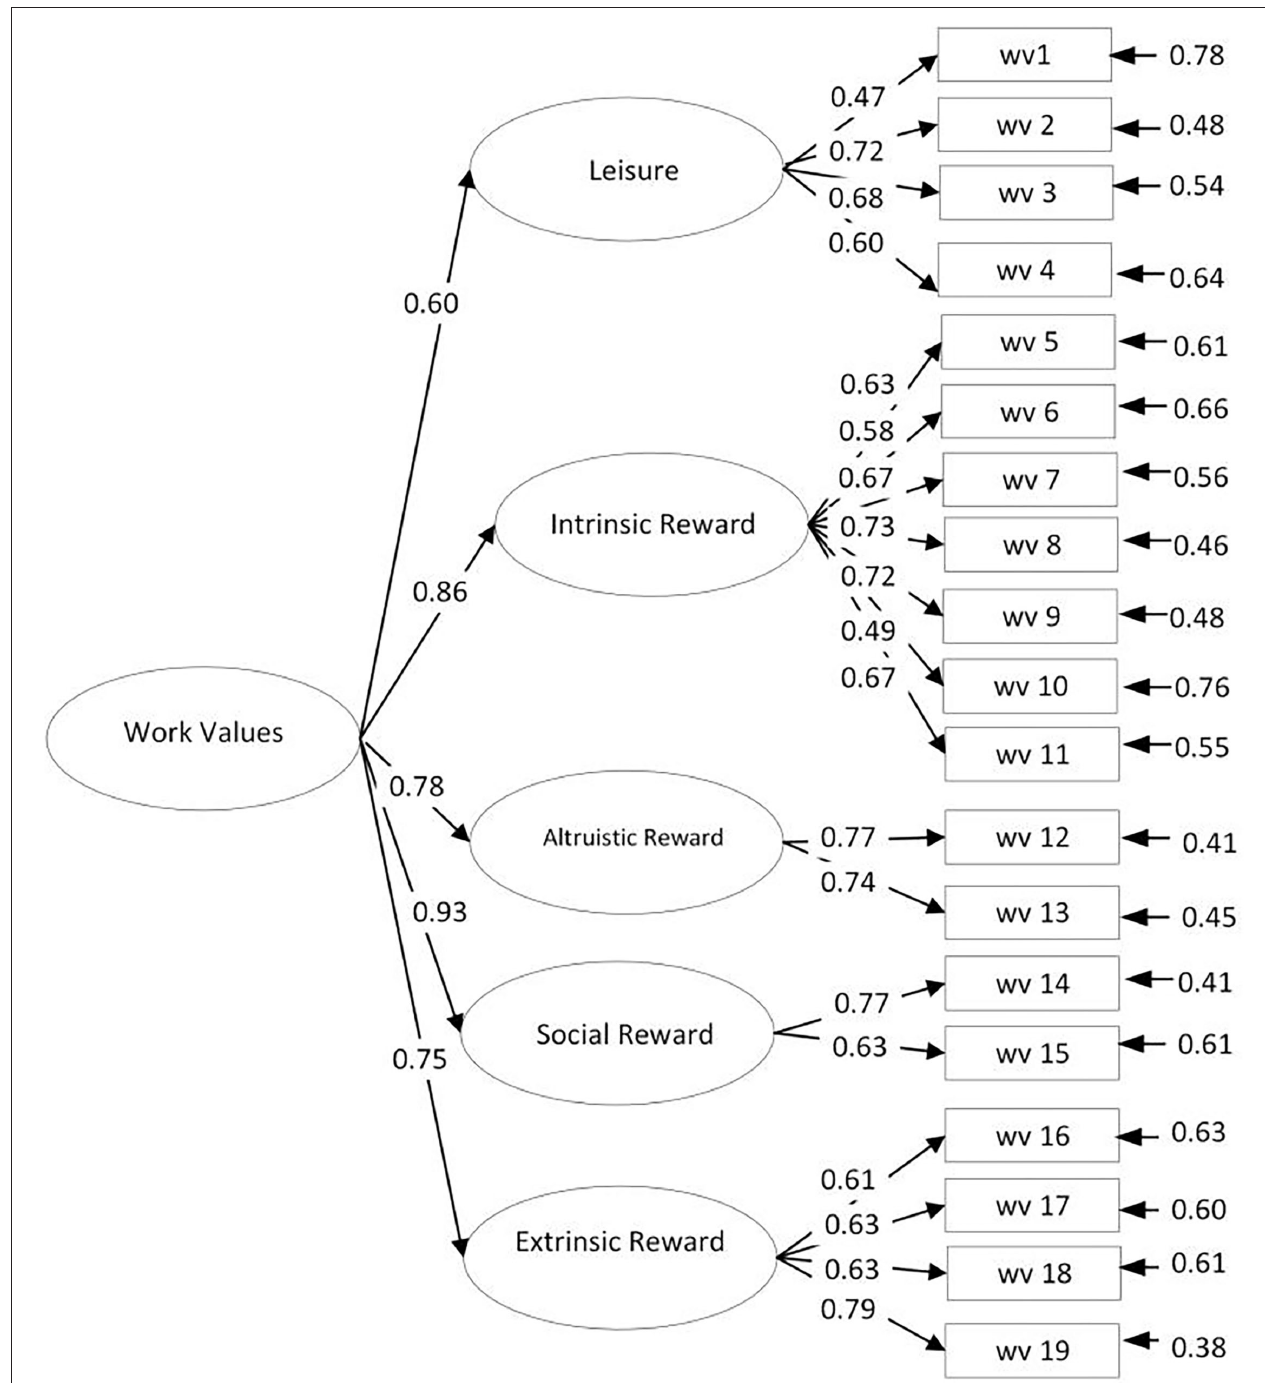
FIGURE 1 | Factor analysis of work